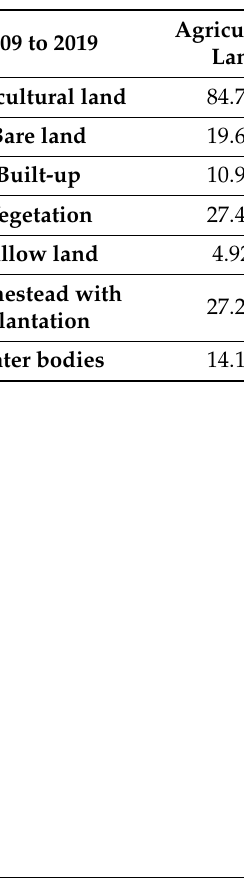
Table 16. Transition matrix (2009 to 2019).